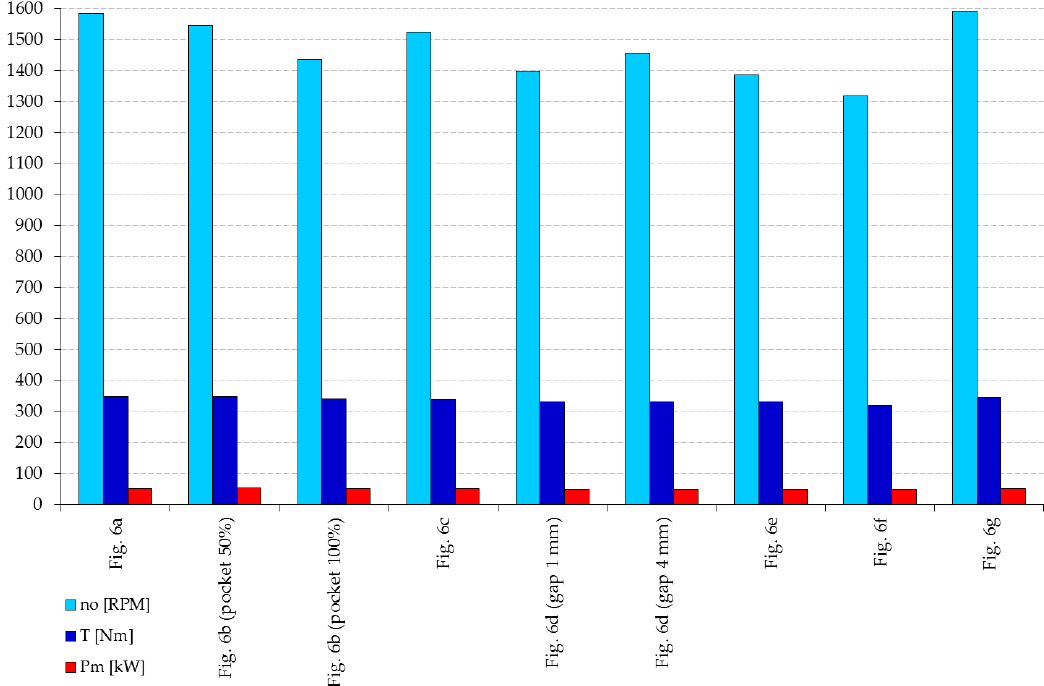
Figure 10. A comparison of rotational speeds, torque and power developed by the motor depending on the method of mounting the magnets.